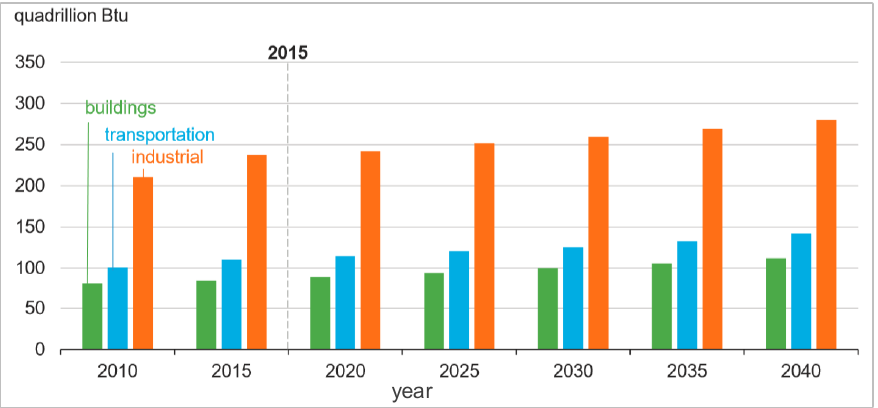
Figure 1. World energy consumption by end-use sector [3].